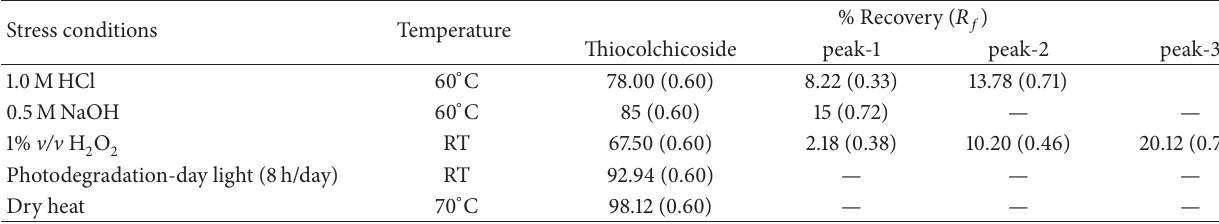
Table 4: Forced degradation studies.